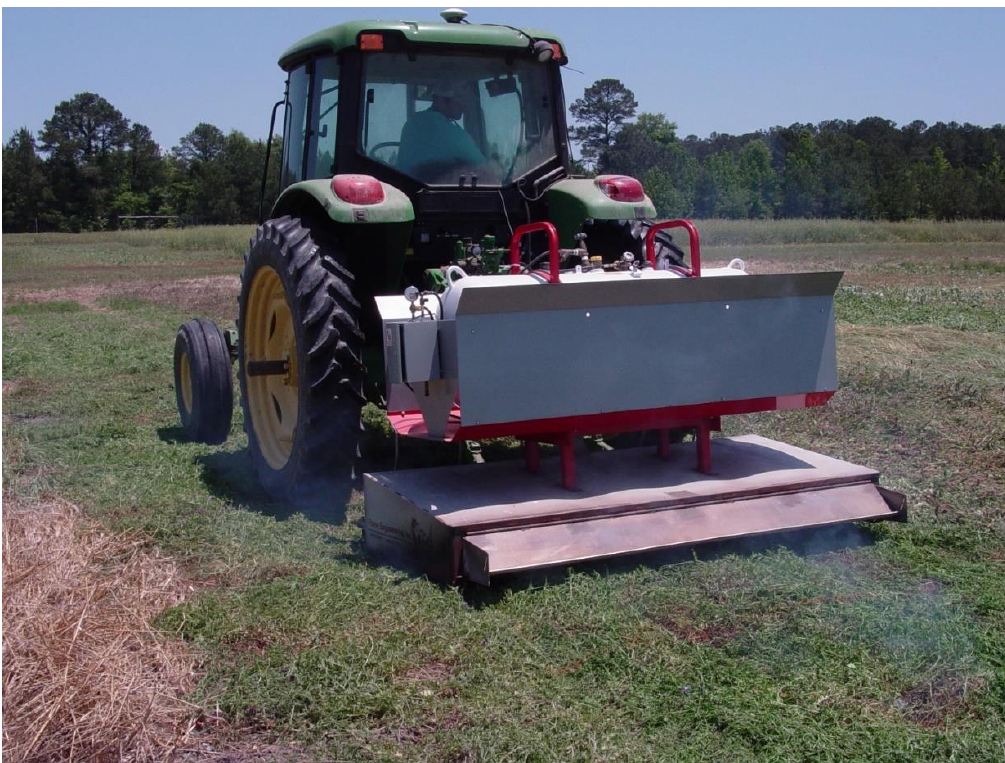
Figure 1. Rolled/crimped hairy vetch winter cover crop being desiccated by a Red Dragon ® Flamer PL-8750 Poultry House Flame Sanitizer, Flame Engineering, Inc., moving at 1.2 k/h and emitting 1100 °C.